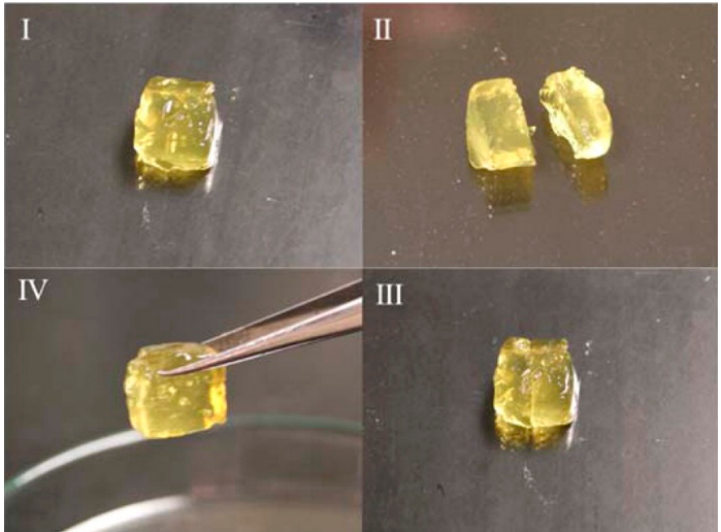
Figure 1. Visual evidence of self-healing of a supramolecular hydrogel through non-covalent host-guest interactions between β -cyclodextrin- and bile acid-bearing polymers: ( I ) initial hydrogel sample; ( II ) sliced sample; ( III ) sliced sample rejoined for healing; and ( IV ) self-healed sample. Reprinted from [63] with permission. Copyright 2016 American Chemical Society.